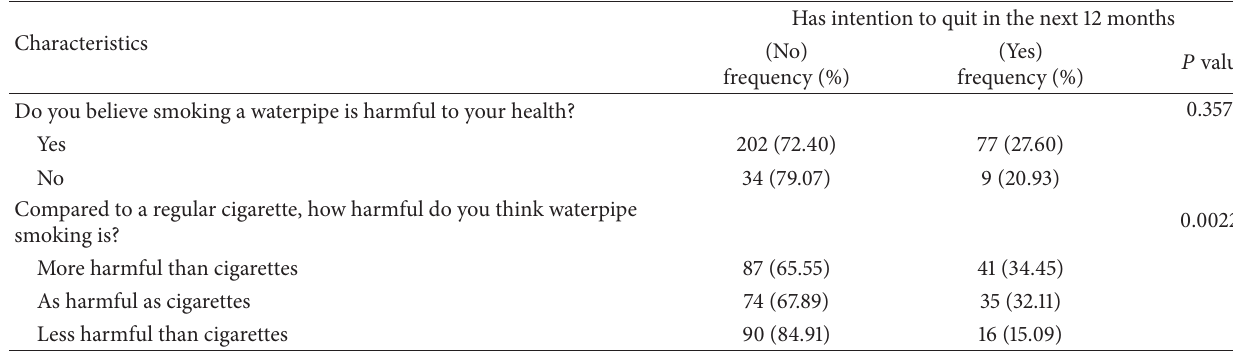
Table 2: Frequency intention to quit waterpipe smoking with perception of